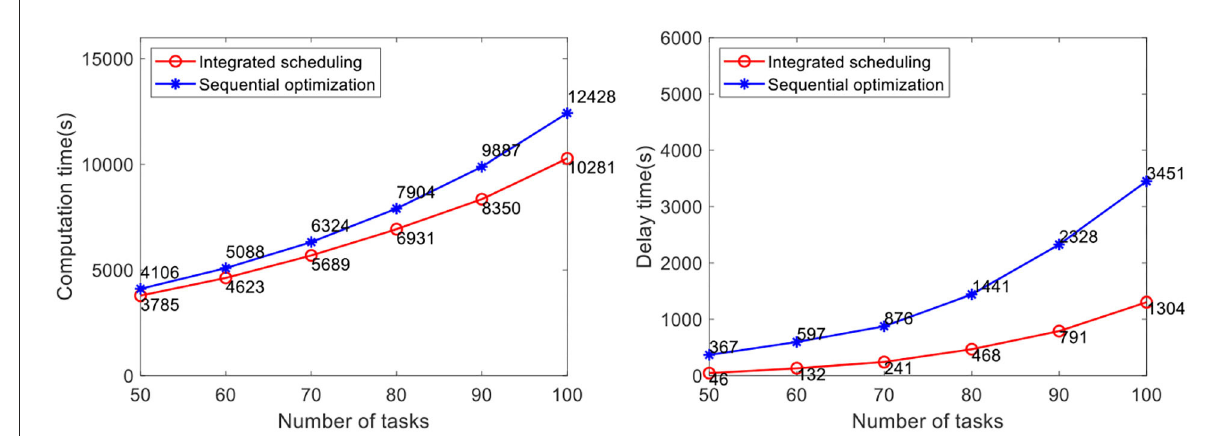
FIGURE11 Comparative analysis of task completion time and delay time with 10 AGVs.